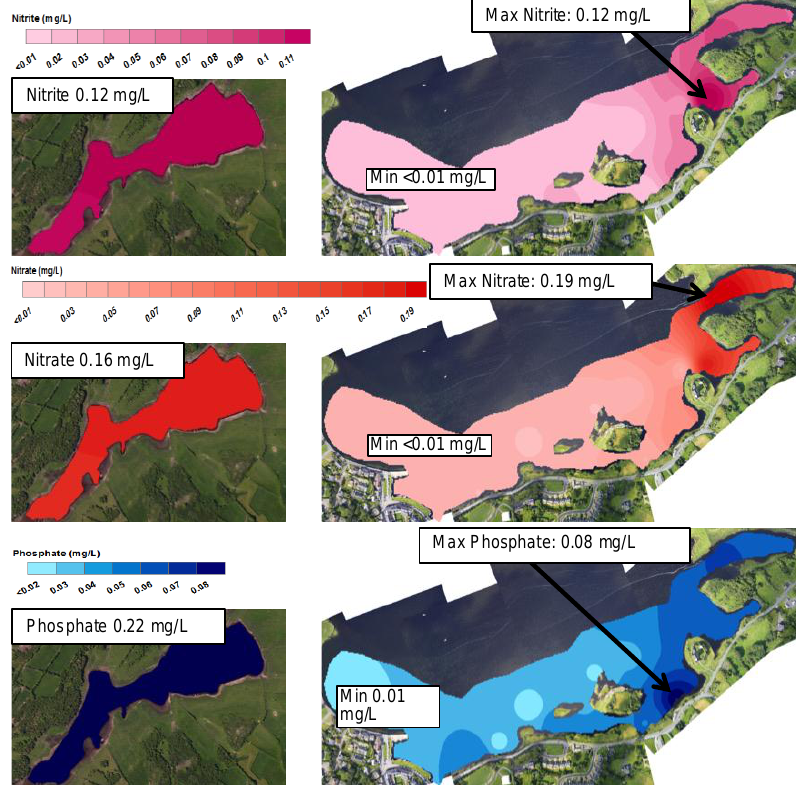
Figure 15. Nitrite ( top ), Nitrate ( middle ) and Phosphate ( bottom ) distribution maps generated from levels found in samples taken at each sampling point within Kinvara Bay and Caherglassuan Turlough at high tide during the sampling campaign (25–28 August 2015).